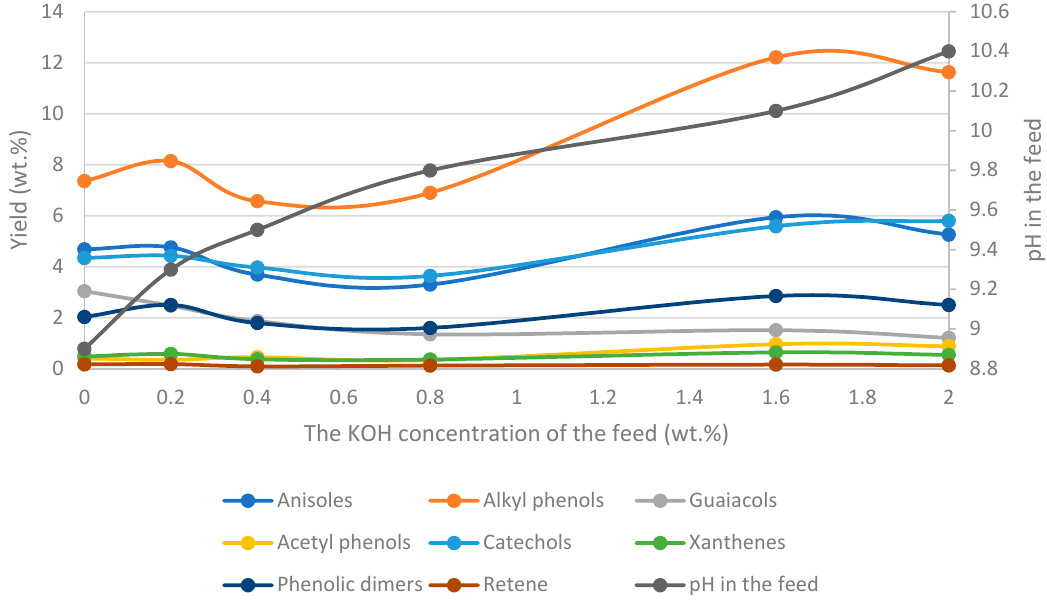
Figure 12. Effect of the initial KOH concentration on the total yields (both WSO and bio-oil) of various components. The feedstock for the HTL process was Kraft lignin. The curves are guides to the eye. Data is taken from Belkheiri et al. [115].